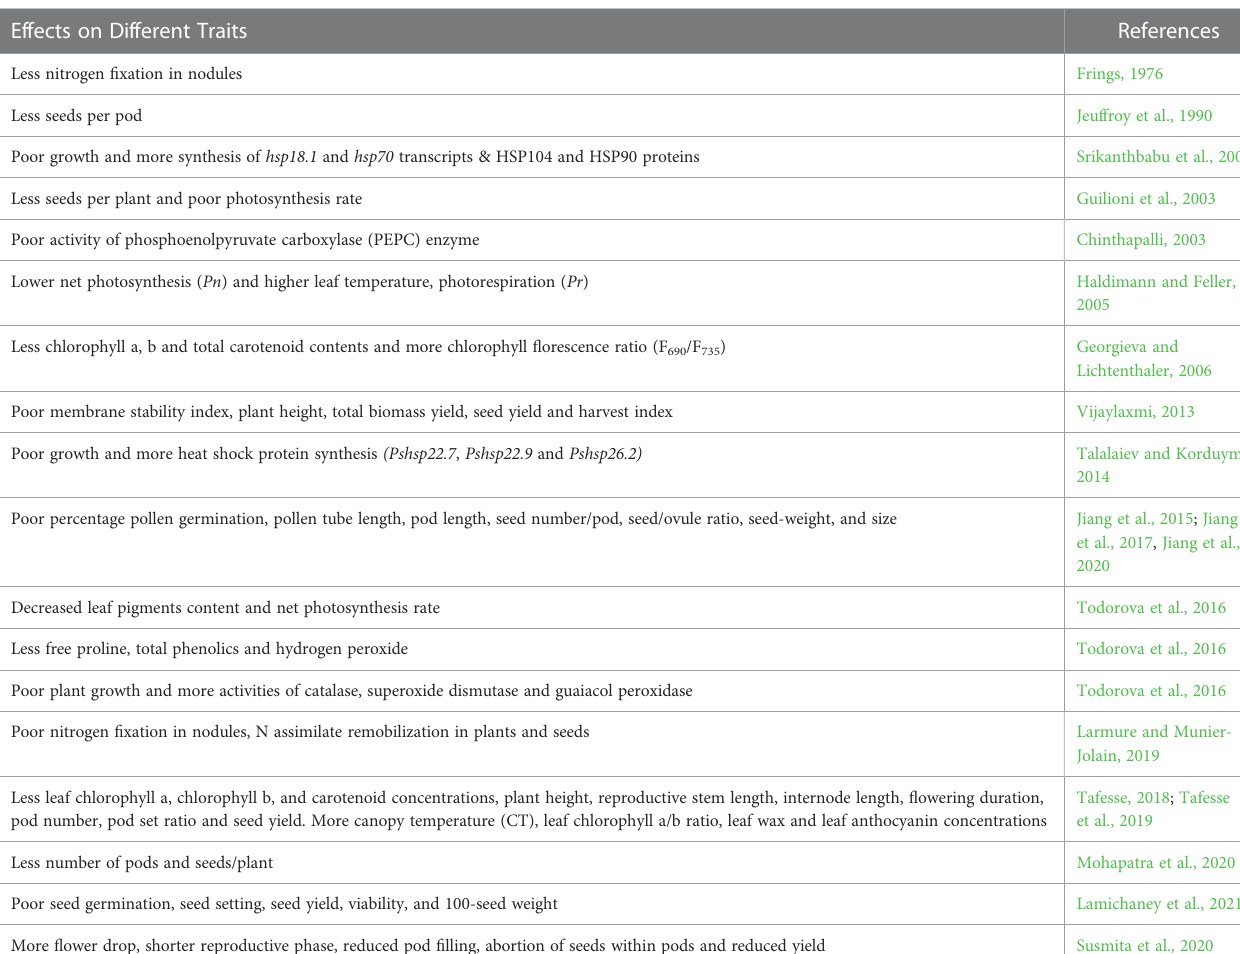
TABLE 1 Effect of heat stress on key physiological, agronomical, and biochemical traits in Pisum . Effects on Different